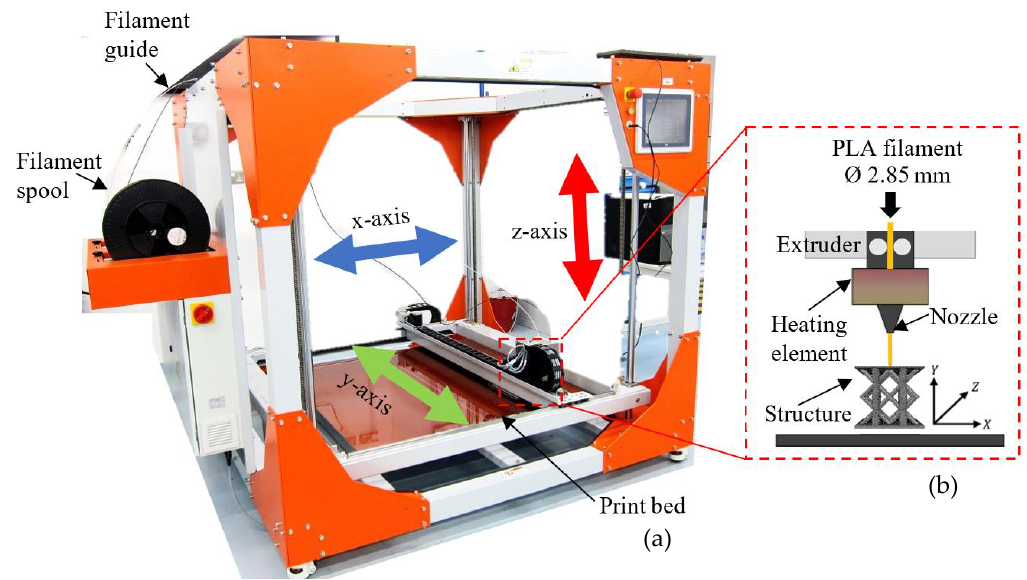
Table 1. Parameters employed for manufacturing the test samples.